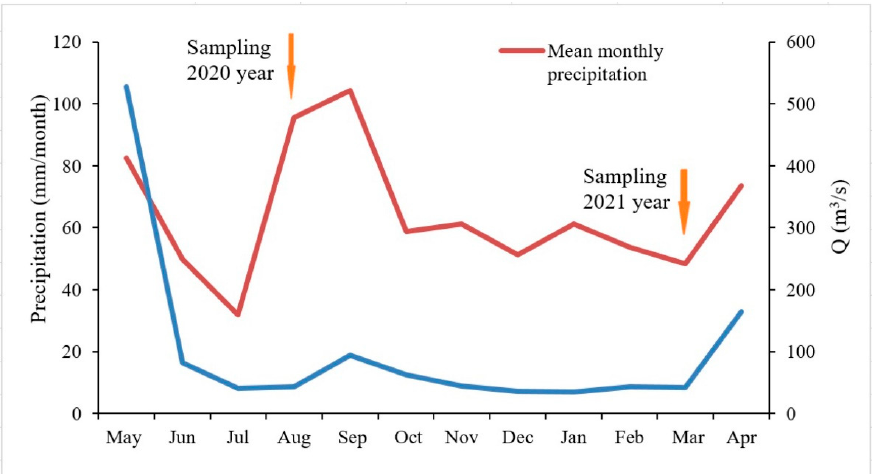
Figure 1 . Mean monthly precipitation at Gubakha weather station and mean monthly streamflow at hydrological station Peremskoe (data period May 2020–April 2021).